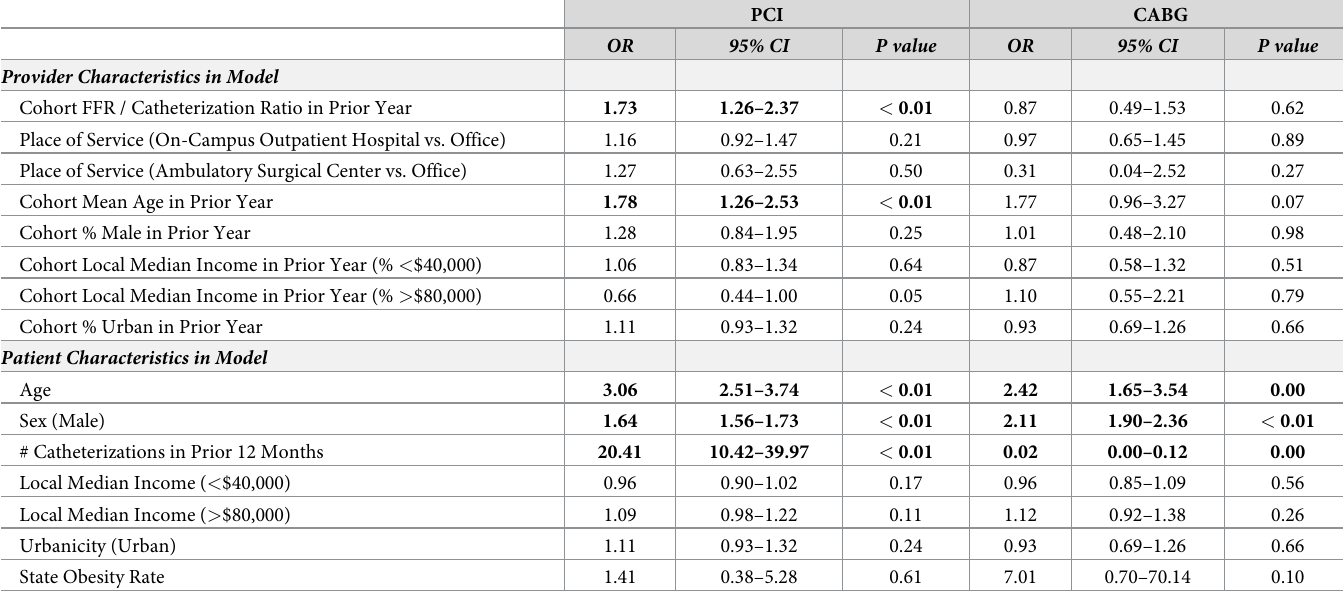
Table 2. Adjusted results from multivariate mixed effects logistic